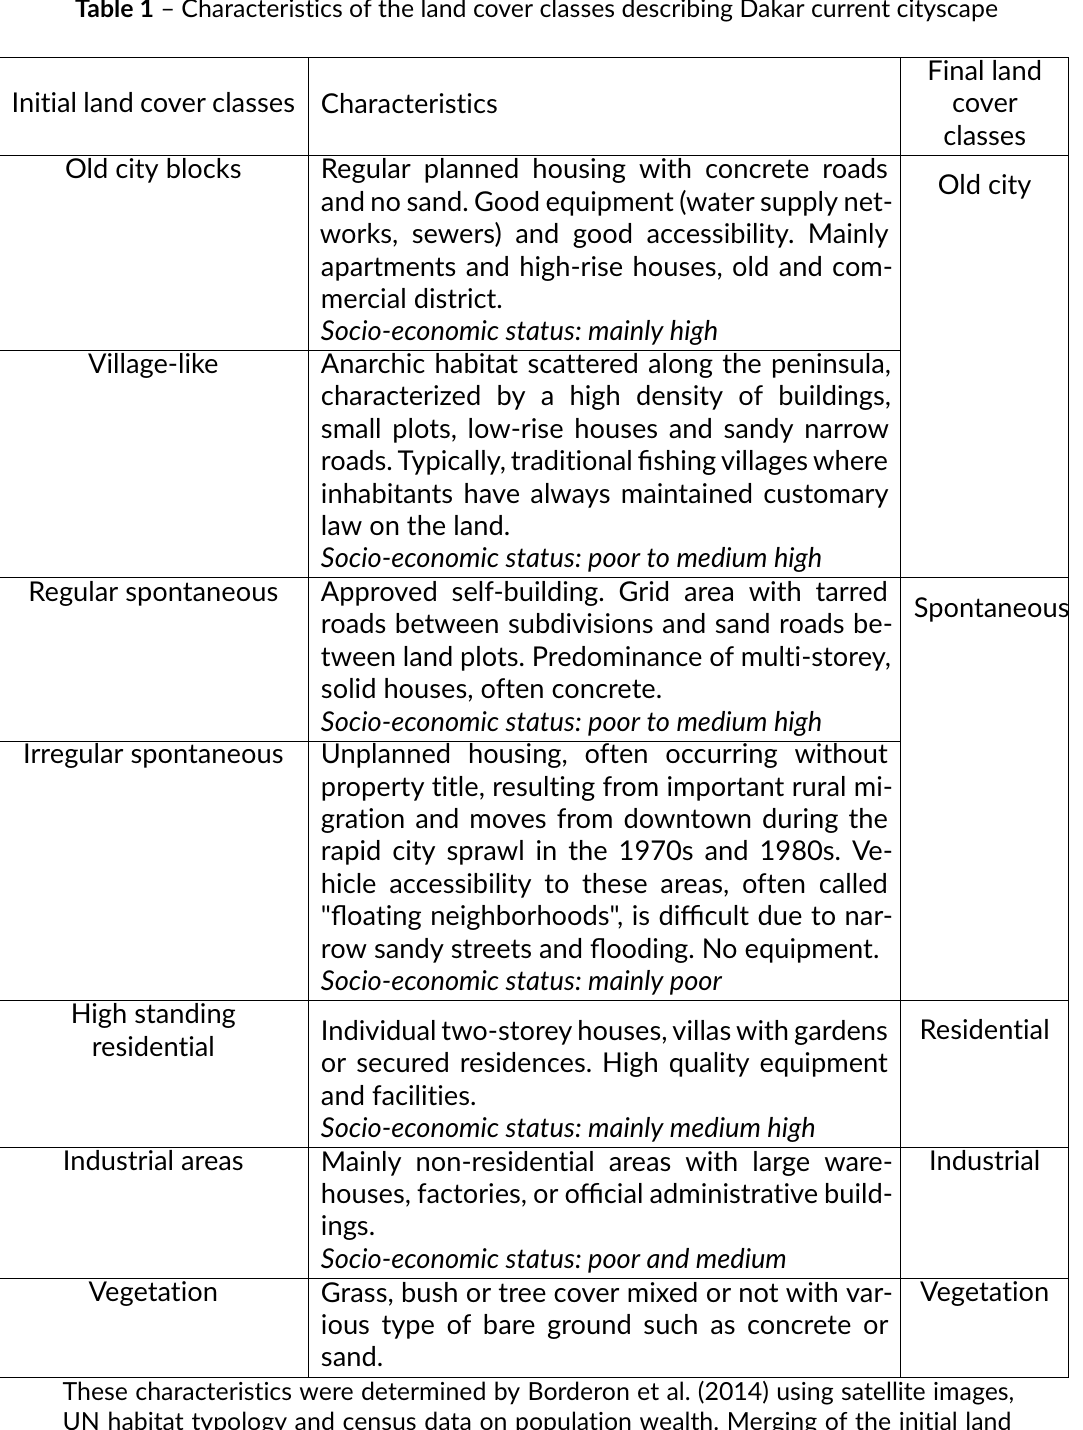
Table 1 – Characteristics of the land cover classes describing Dakar current